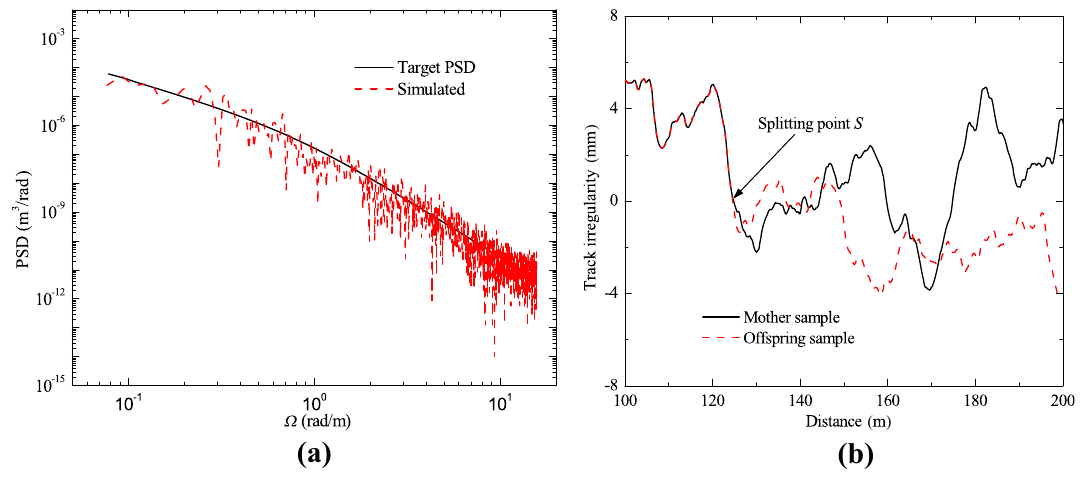
Fig. 3 Simulation of track irregularity: a power spectrum and b track irregularity of offspring